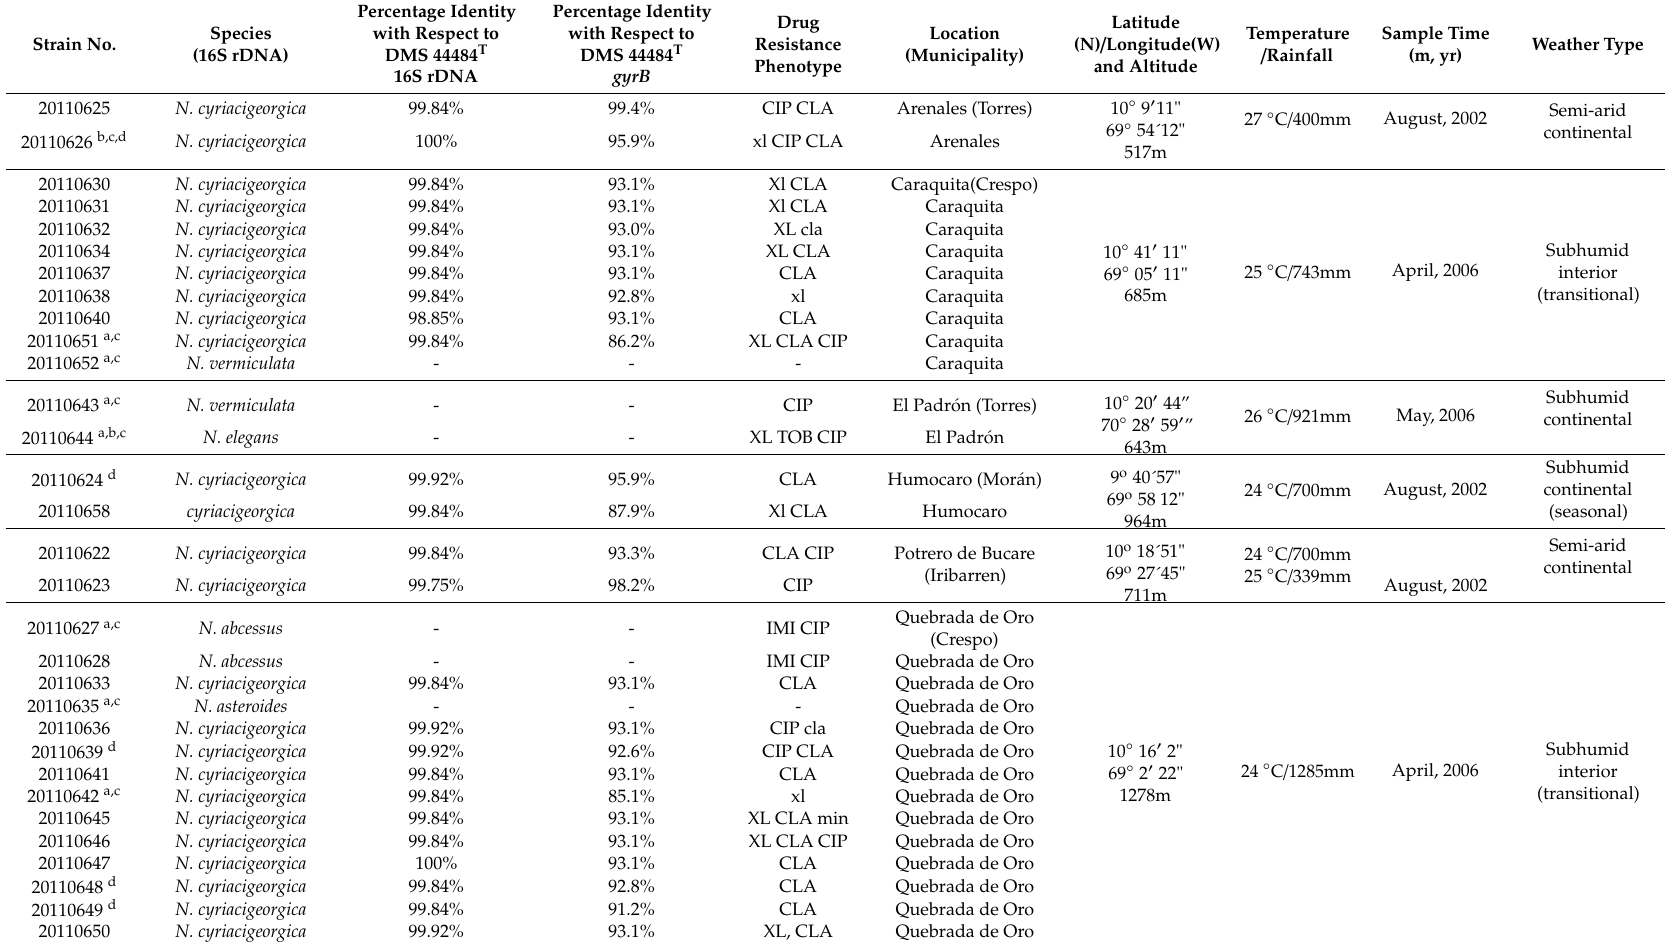
Table 1. Characteristics of the Nocardia spp. soil strains isolated in Lara State,